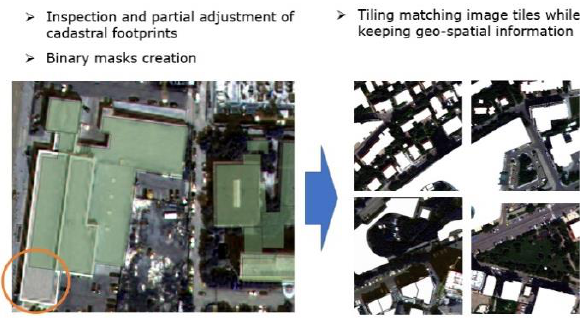
Figure 5. Ground Truth pre-processing.